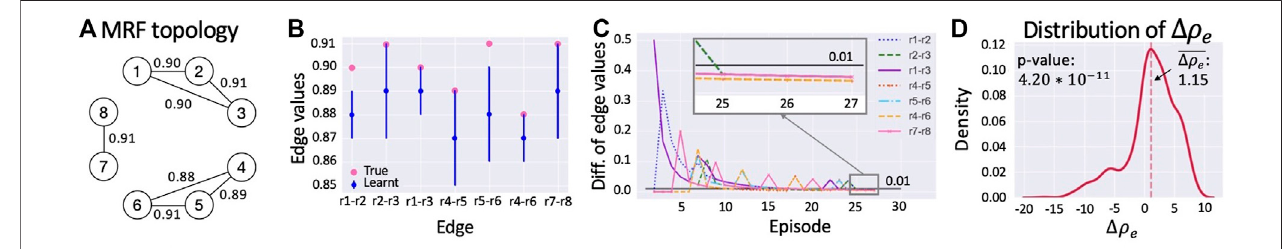
learned MRF in EXT with respect to STD that does not use any kind of prior knowledge. The value of Δ ρ e is 1.15 and corresponds to a performance improvement of 5.99% ( Figure 5D ). The distribution and corresponding average difference is computed over 100 episodes and 10 runs. To verify that Δ ρ e is statistically different from zero, we perform the Student ’ s t -test that con fi rms the statistical signi fi cance of the result as the p -value is lower than